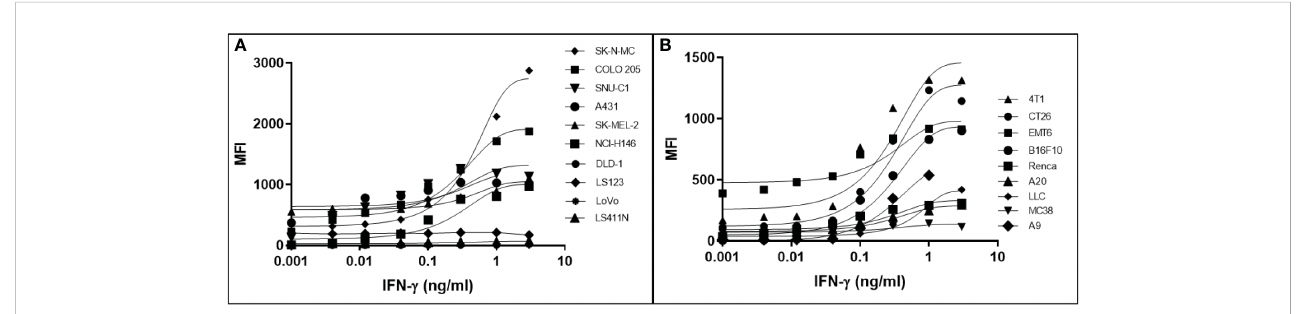
FIGURE 1 Downregulation of MHC-I expression is reversible by in most human (A) and mouse (B) cancer cell lines. The MHC-1-low or -null cell lines were treated with a titration of human (A) or mouse (B) IFN- g for 48 hr, washed, and MHC-I expression determined by fl ow cytometry. The pan-human HLA antibody, W6/32, was used to stain the human cell lines, and mouse cell lines were stained with the MHC-I allotype-speci fi c 34-1-2S (4T1, CT26, EMT6, Renca, A20) or 28-8-6 (B16-410, LLC, MC38, A9)